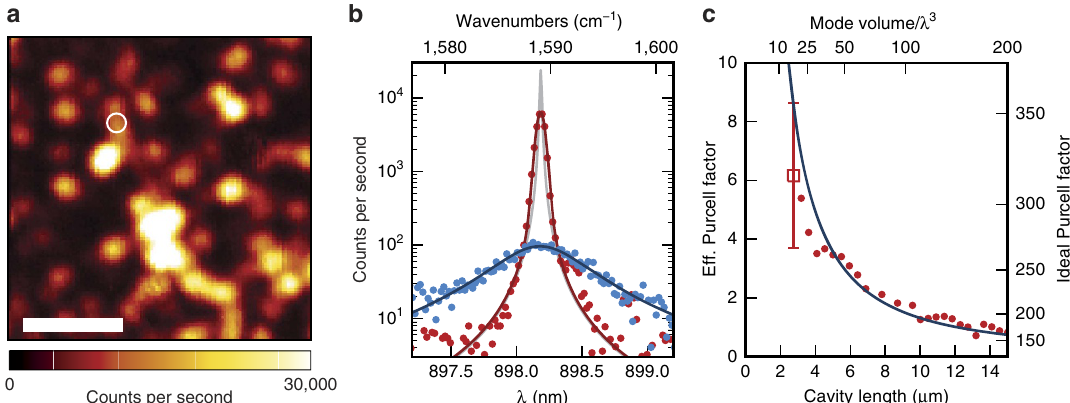
Figure 3 | Cavity-enhanced Raman imaging and quantification of the Purcell enhancement. ( a ) Raman map showing the strength of the G þ band with the cavity actively stabilized on resonance with the Raman transition. Scale bar, 10 m m. ( b ) Spectra taken at the location of the circle in a with a confocal microscope (blue data points with Lorentzian fit) and the stabilized cavity at a cavity length d ¼ 2.75 m m (red data points with Voigt fit) normalized to the same intensity at the nanotube. The grey line shows the intrinsic cavity resonance. ( c ) Scaling of the integrated cavity-enhanced Raman intensity (red data points) as a function of the effective length of the cavity. The red square is evaluated from the measurement shown in b , and the solid line is the theoretically predicted ideal and effective Purcell factor. The error bar is the estimated experimental uncertainty (95% confidence